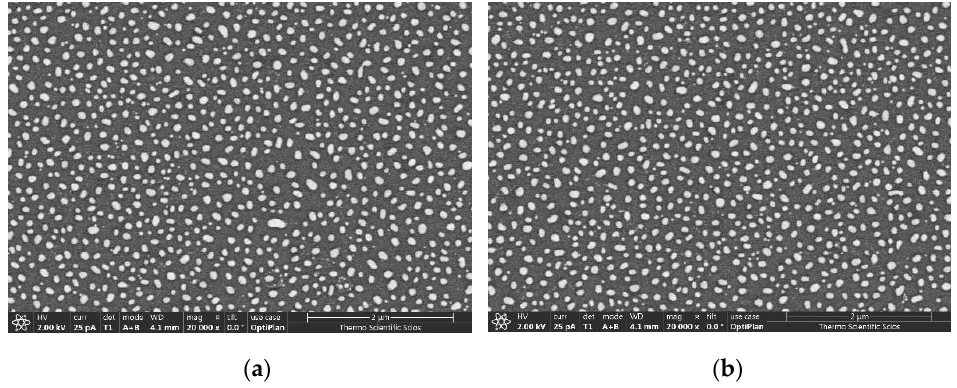
Figure 1. SEM image of a gold nanoislands sample (Sample 7): ( a ) freshly prepared; ( b ) after wash- ing.